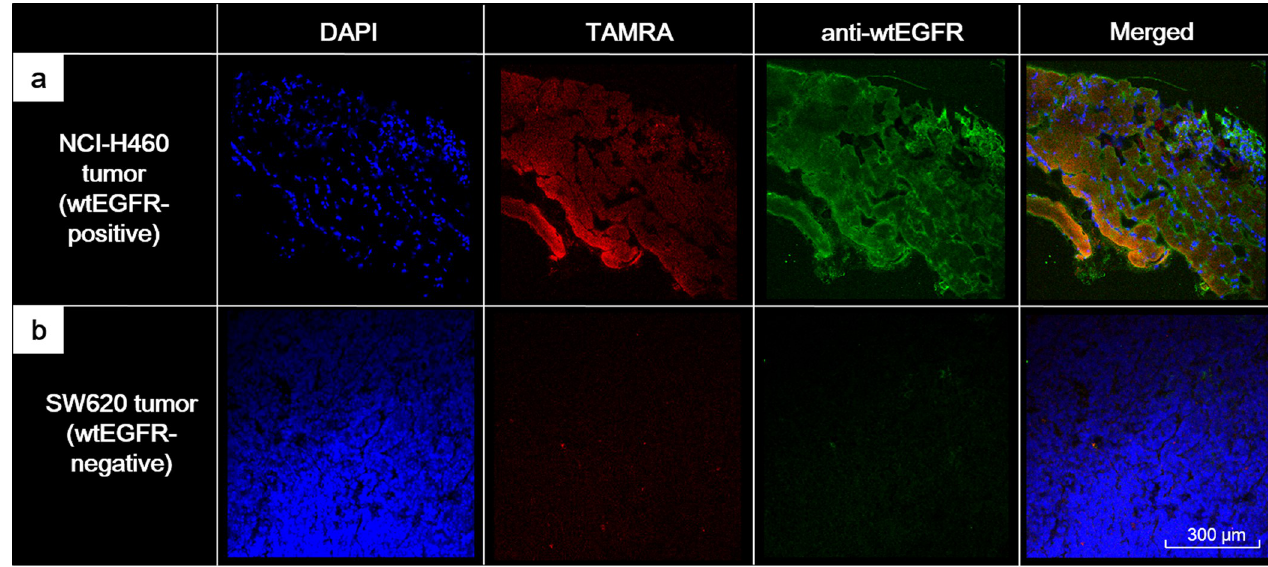
Fig 6. (a) On confocal microscopy with immunohistochemical staining, evident fluorescent TAMRA activities of Tc-99m SYPIPDT-ECG-TAMRA were detected within NCI-H460 tumor tissue, consistent with anti-wtEGFR antibody staining. (b) Fluorescent activity of TAMRA and anti-wtEGFR antibody was barely detected in the SW620 tumor tissue.